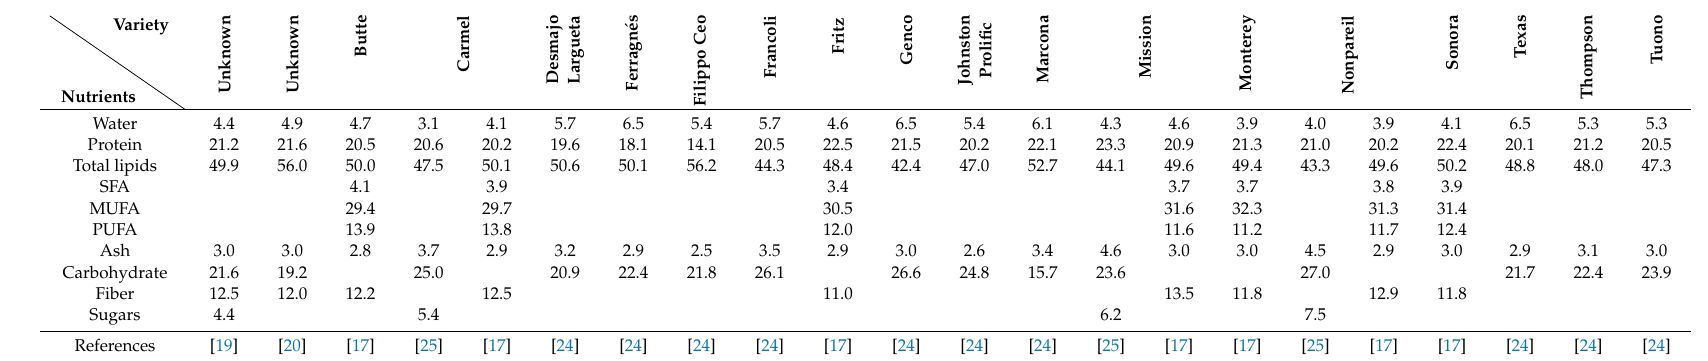
Table 1. Nutritional composition (g / 100 g) of di ff erent varieties of almonds ( Prunus dulcis Mill. D. A. Webb).